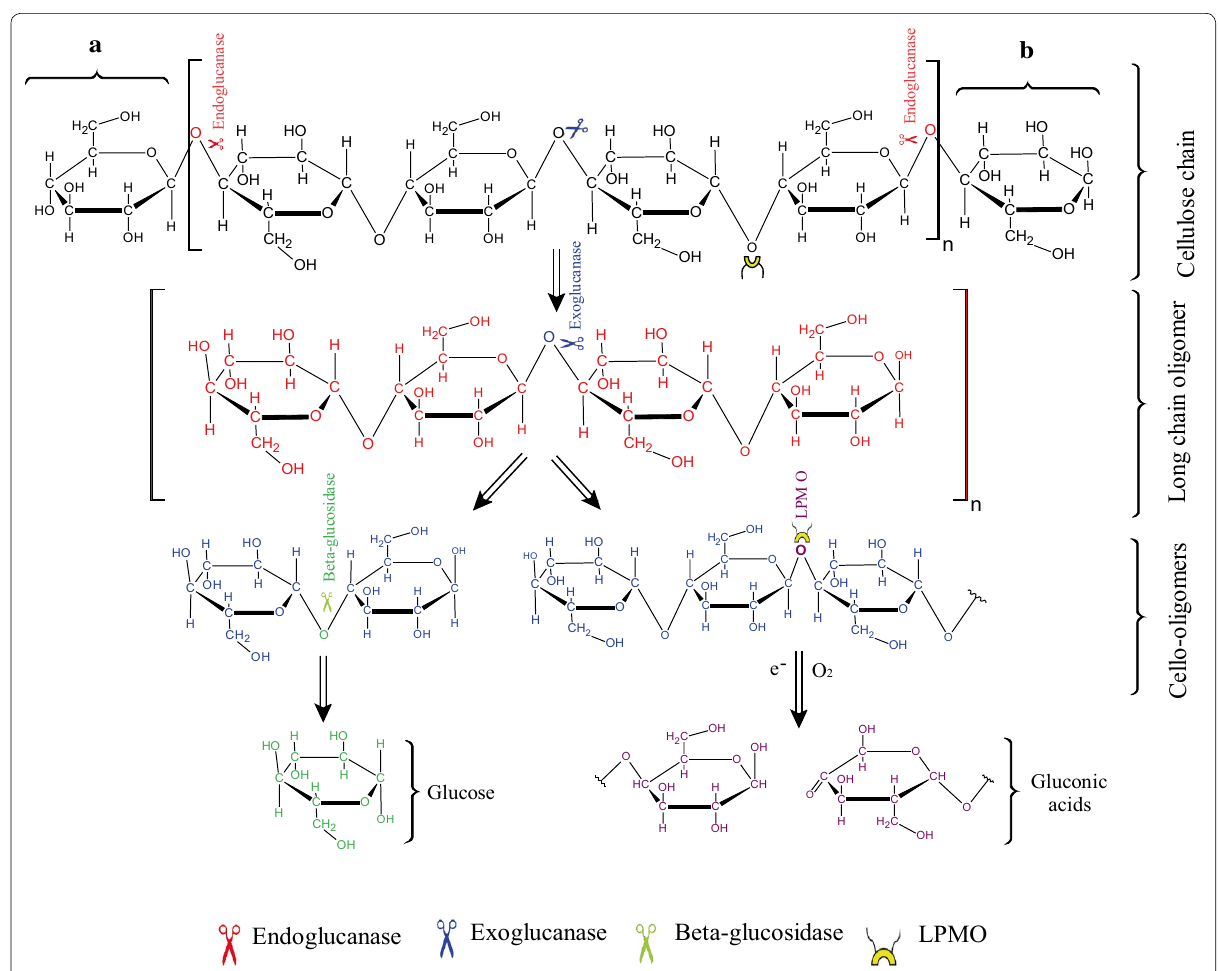
Fig. 2 Cellulase hydrolysis theory. a The non-reducing end; b the reducing end. Endoglucanase cleaves amorphous sites of cellulose to yield long- chain oligomers; exoglucanase processively attacks crystalline sites to produce cello-oligomers; and β-glucosidase hydrolyzes cellobiose to ferment- able sugars. Lytic polysaccharide mono-oxygenase (LPMO) oxidizes glycosidic linkages along the cellulose chain to yield gluconic